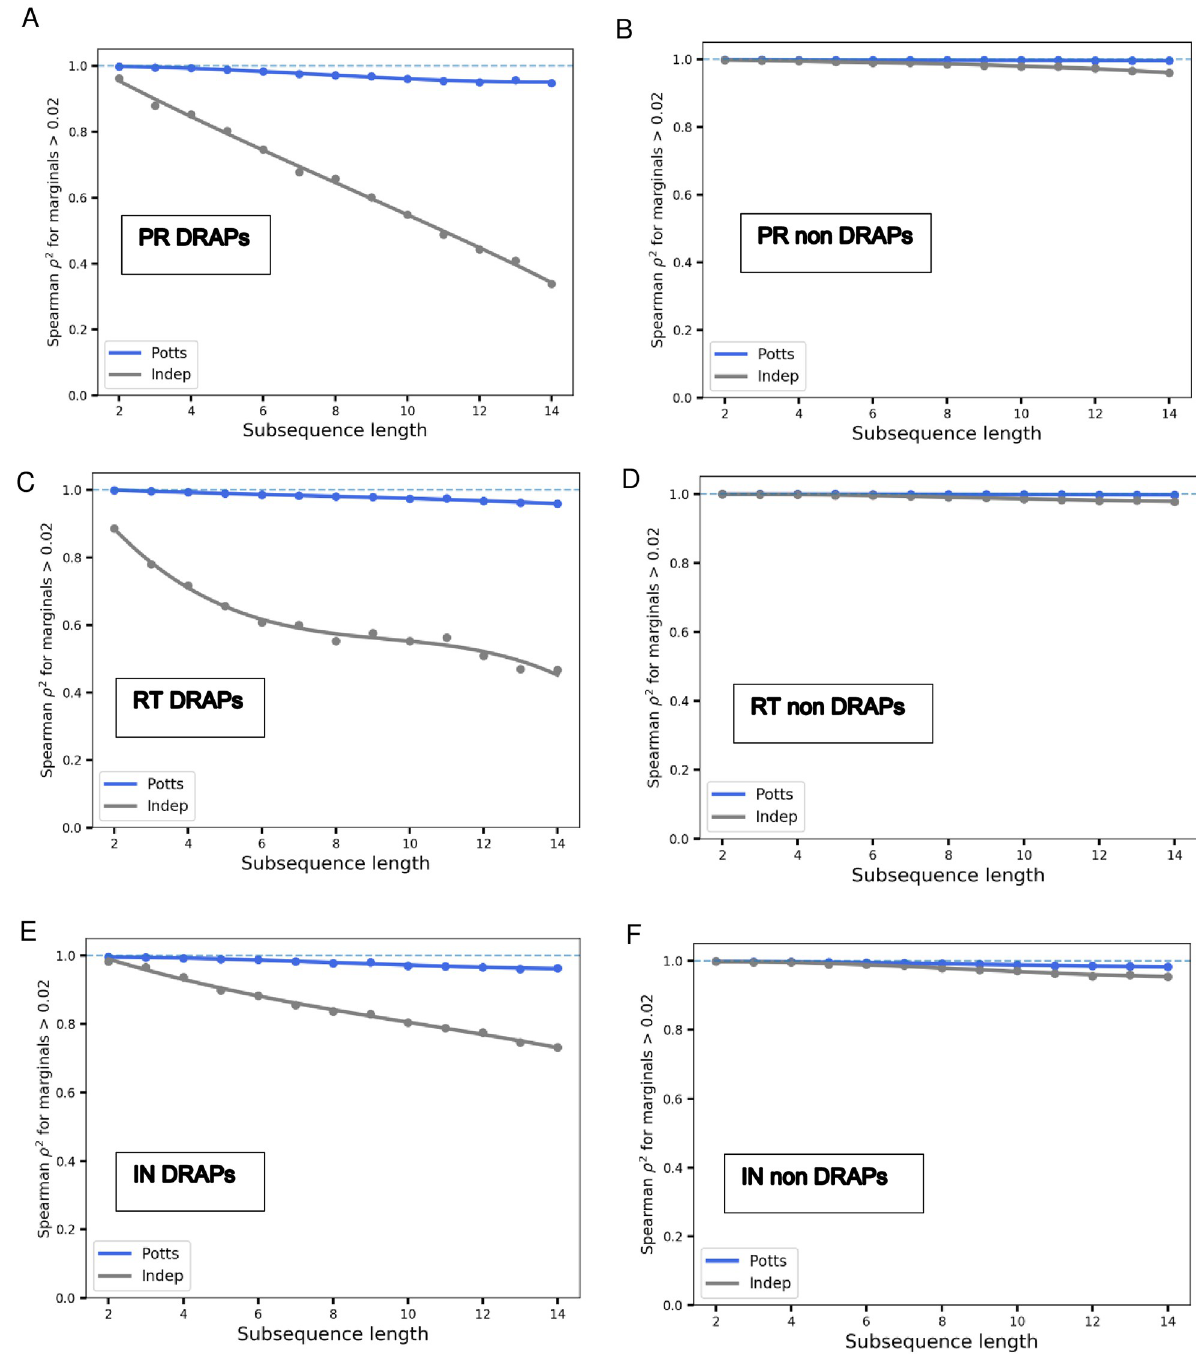
Fig 3. Potts model is predictive of higher-order marginals in the sequence MSA. For each subsequence of length 2 to 14, marginal frequencies are determined by counting the occurrences in the MSA and computed for 500 randomly picked subsequences. They are compared with the corresponding predictions of marginal probabilities by the Potts model (blue) and a site-independent model (gray). The Spearman ρ 2 between the dataset marginal frequencies and the Potts and independent model predictions for all marginal frequencies above 2% are shown for subsequences picked at random from different combinations of 36 Protease-inhibitor or PI-associated positions in PR (A), 24 Nucleoside-reverse-transcriptase- inhibitor or NRTI-associated positions in RT (C), and 31 Integrase-strand-transfer-inhibitor or INSTI-associated positions in IN (E). Shown in (B), (D), (F), are the same but the subsequences are picked at random from non resistance-associated sites in PR, RT, and IN, respectively. The blue dashed line represents perfect correlation of ρ 2 = 1. In all, the Potts model accurately captures the higher-order marginals in the dataset; the independent model however gets progressively worse in capturing the higher-order marginals for resistance-associated sites in (A), (C), and (E). The